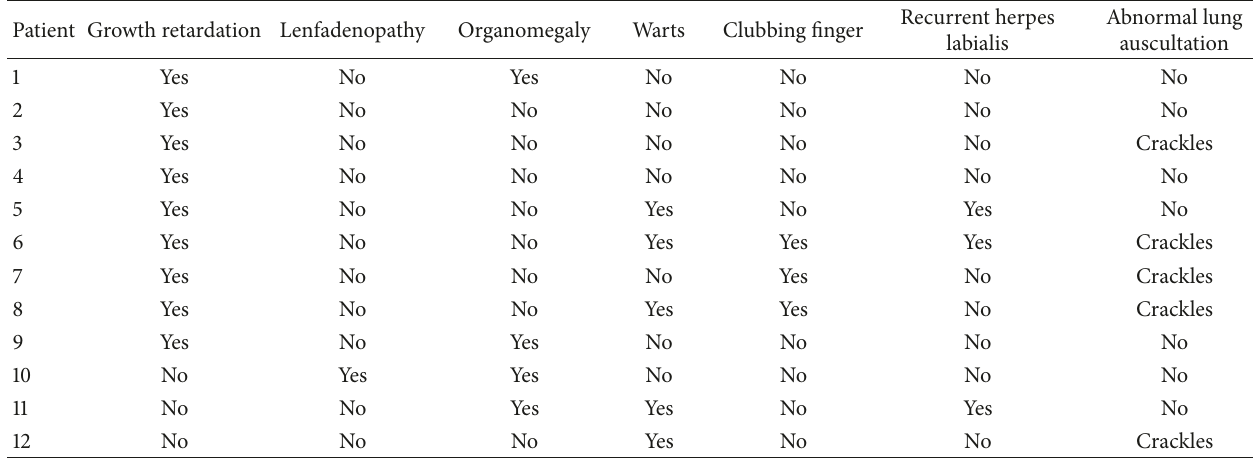
Patient Growth retardation